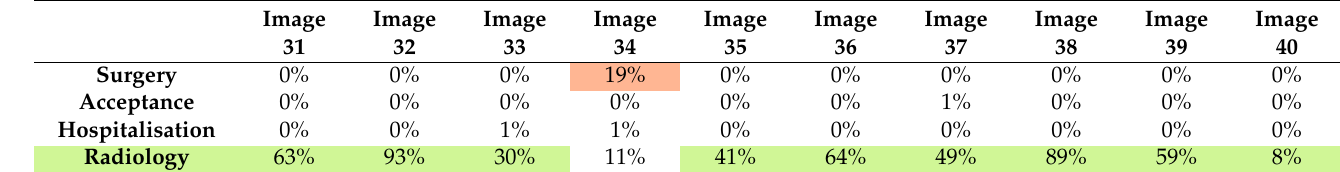
Table 10. Results obtained with the second version of the customised model for the “radiology” IU. Each column refers to one of the test images (31 to 40) and each row shows the labels that were returned by the model. The row–column intersection shows the success rate in recognising the concept stated in the row for the image in that column.